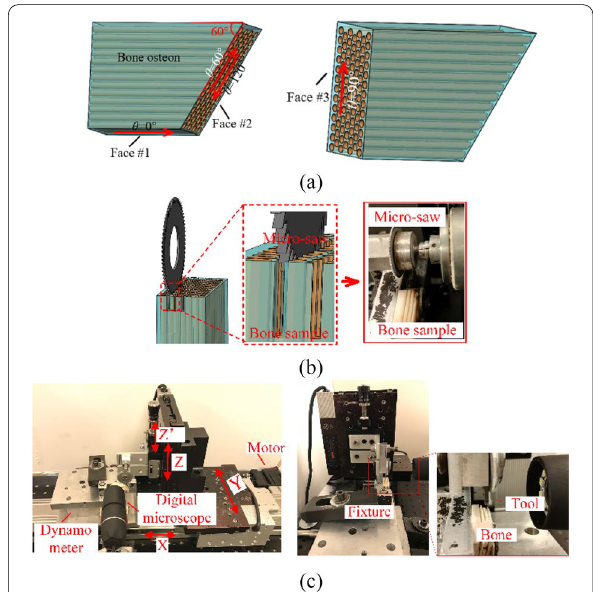
Figure 8 Chip morphologies a h and d h 130 μm in mode =